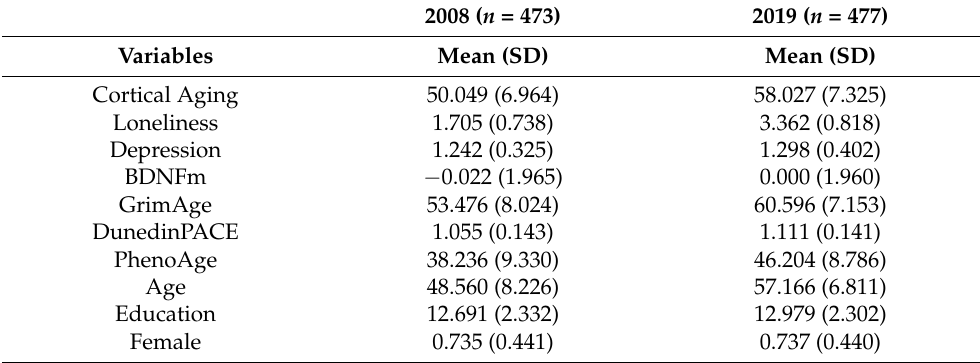
Table 1. Descriptive statistics for the study variables.